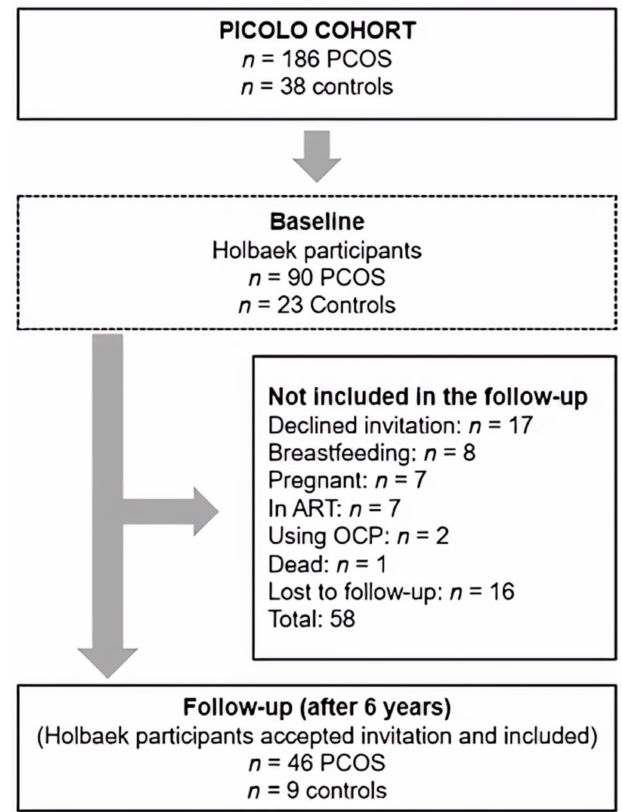
Figure 1. Flowchart of included women with PCOS and controls at BL and at